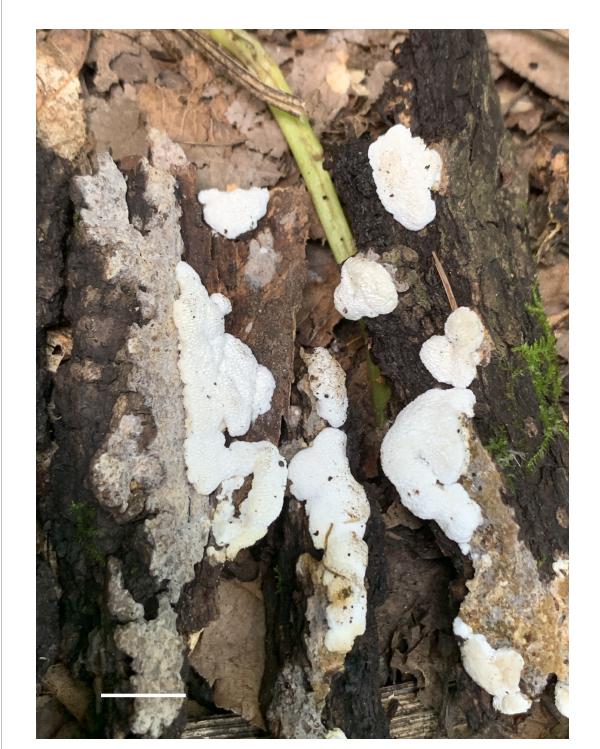
FIGURE 4 Basidiomata of Haploporus monomitica (Holotype, Dai 24446). Scale bar = 1 cm. Photo by Yu-Cheng